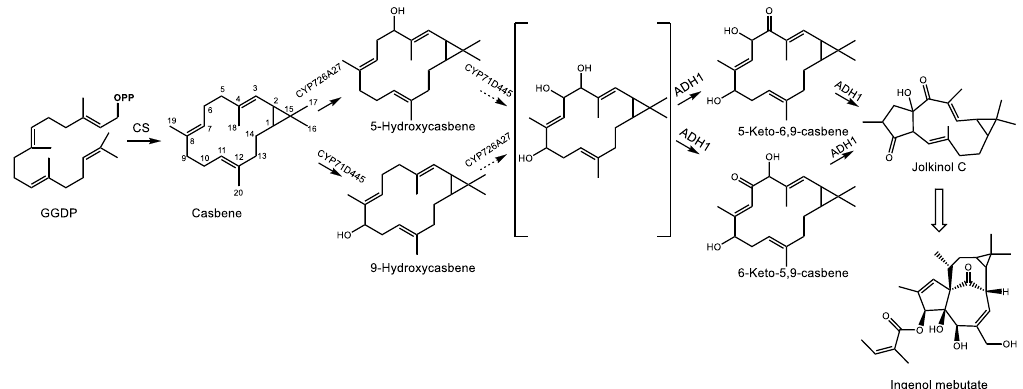
Figure 9. Proposed pathway for the initial steps leading to the Euphobia factor ingenol mebutate in Euphorbia spp. , as per [168]. GGDP represents geranylgeranyl diphosphate and OPP signifies a diphosphate group. Enzyme abbreviations: CS-casbene synthase, CYP726A27–cytochrome P450 726A27, CYP71D445–cytochrome P450 71D445, ADH1–alcohol dehydrogenase